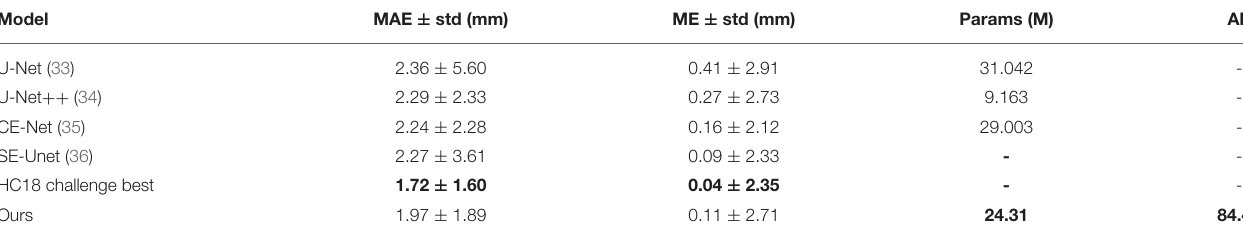
TABLE 1 | The comparison results between our method and other common methods base on segmentation algorithm.